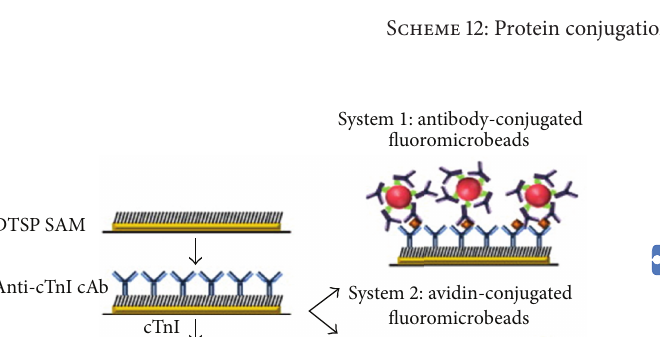
Scheme 12: Protein conjugation to polystyrene NP.